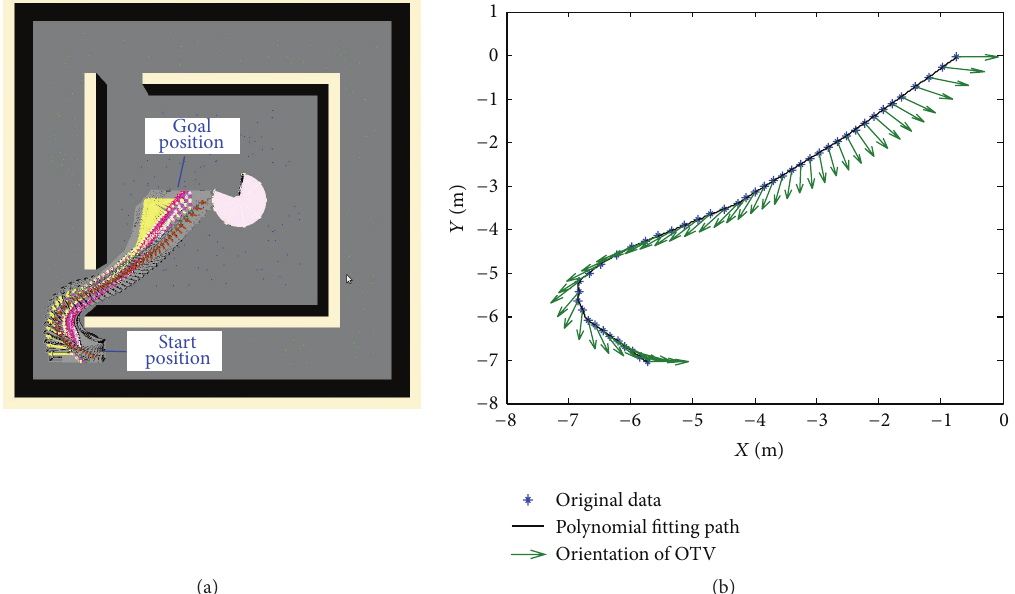
Figure 4: Planning result of RRT-Connect planner (a) and the polynomial fitting path with respect to the orientation of the vehicle